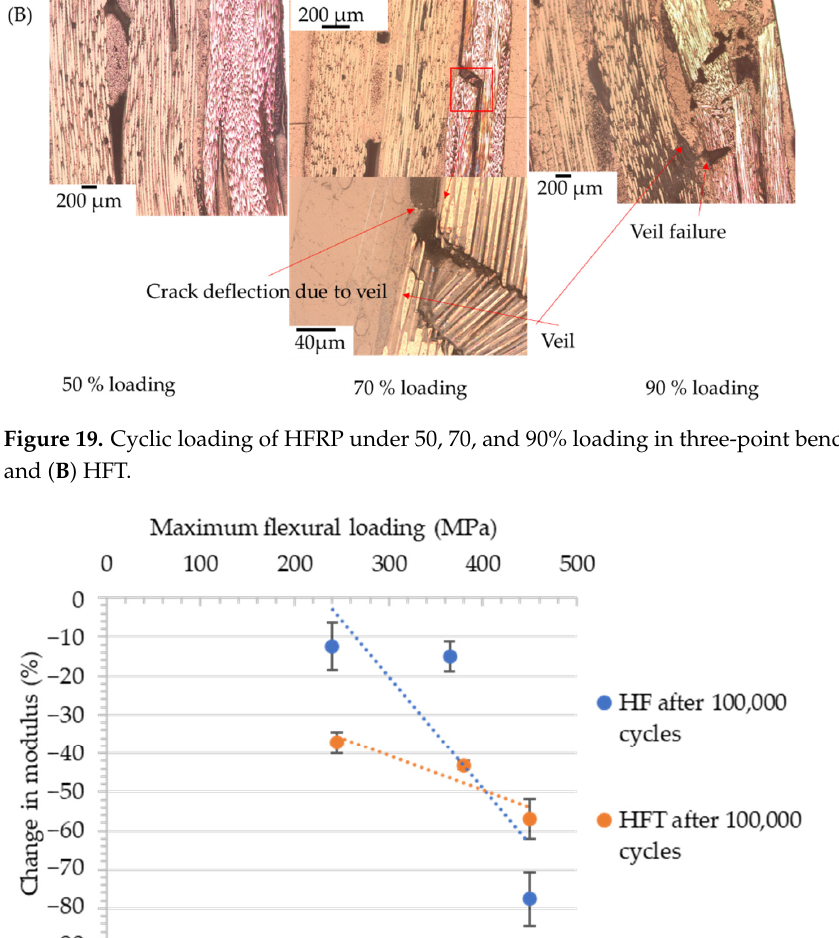
Figure 21. PA 6,6 nanofibre crack bridging in HFT and CFT . At 90% maximum loading, the HFT sample reached 100,000 cycles, in comparison to the HF, which failed after 40,000 cycles. For all three coupons, the HF samples failed with an average of 9.49 GPa flexural modulus, with HFT having an average flexural modulus of 23.20 ± 5.13 GPa. Using optical microscopy, the fibre failure leading to stiffness degra ‐ dation was shown in both the carbon fibre and glass fibre layers. 3.4. Comparison of Cycles and Flexural Modulus Retention The importance of the veil in reducing matrix cracking from propagating into delam ‐ ination failure is shown in Figure 22. The cracking was unchanged with the presence of veil; although, compared with the control fibre samples, the propagations of these cracks show that, over time, there was a retention in the modulus.